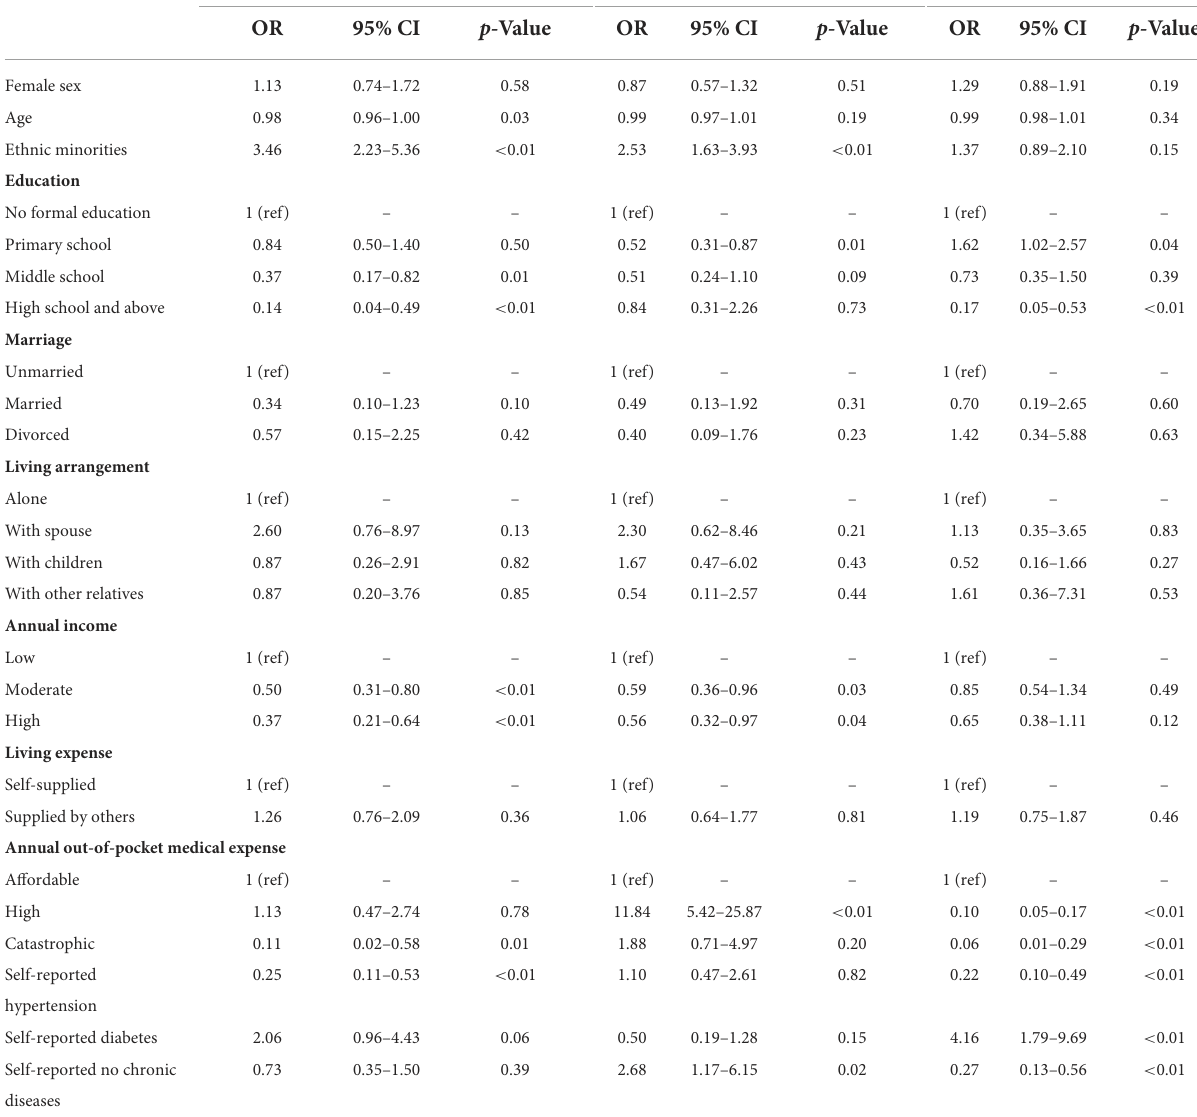
TABLE 2 Logistic regression analysis of differences in characteristics across KAP latent profile groups. Incomplete transfer vs. Better practice Incomplete transfer vs.